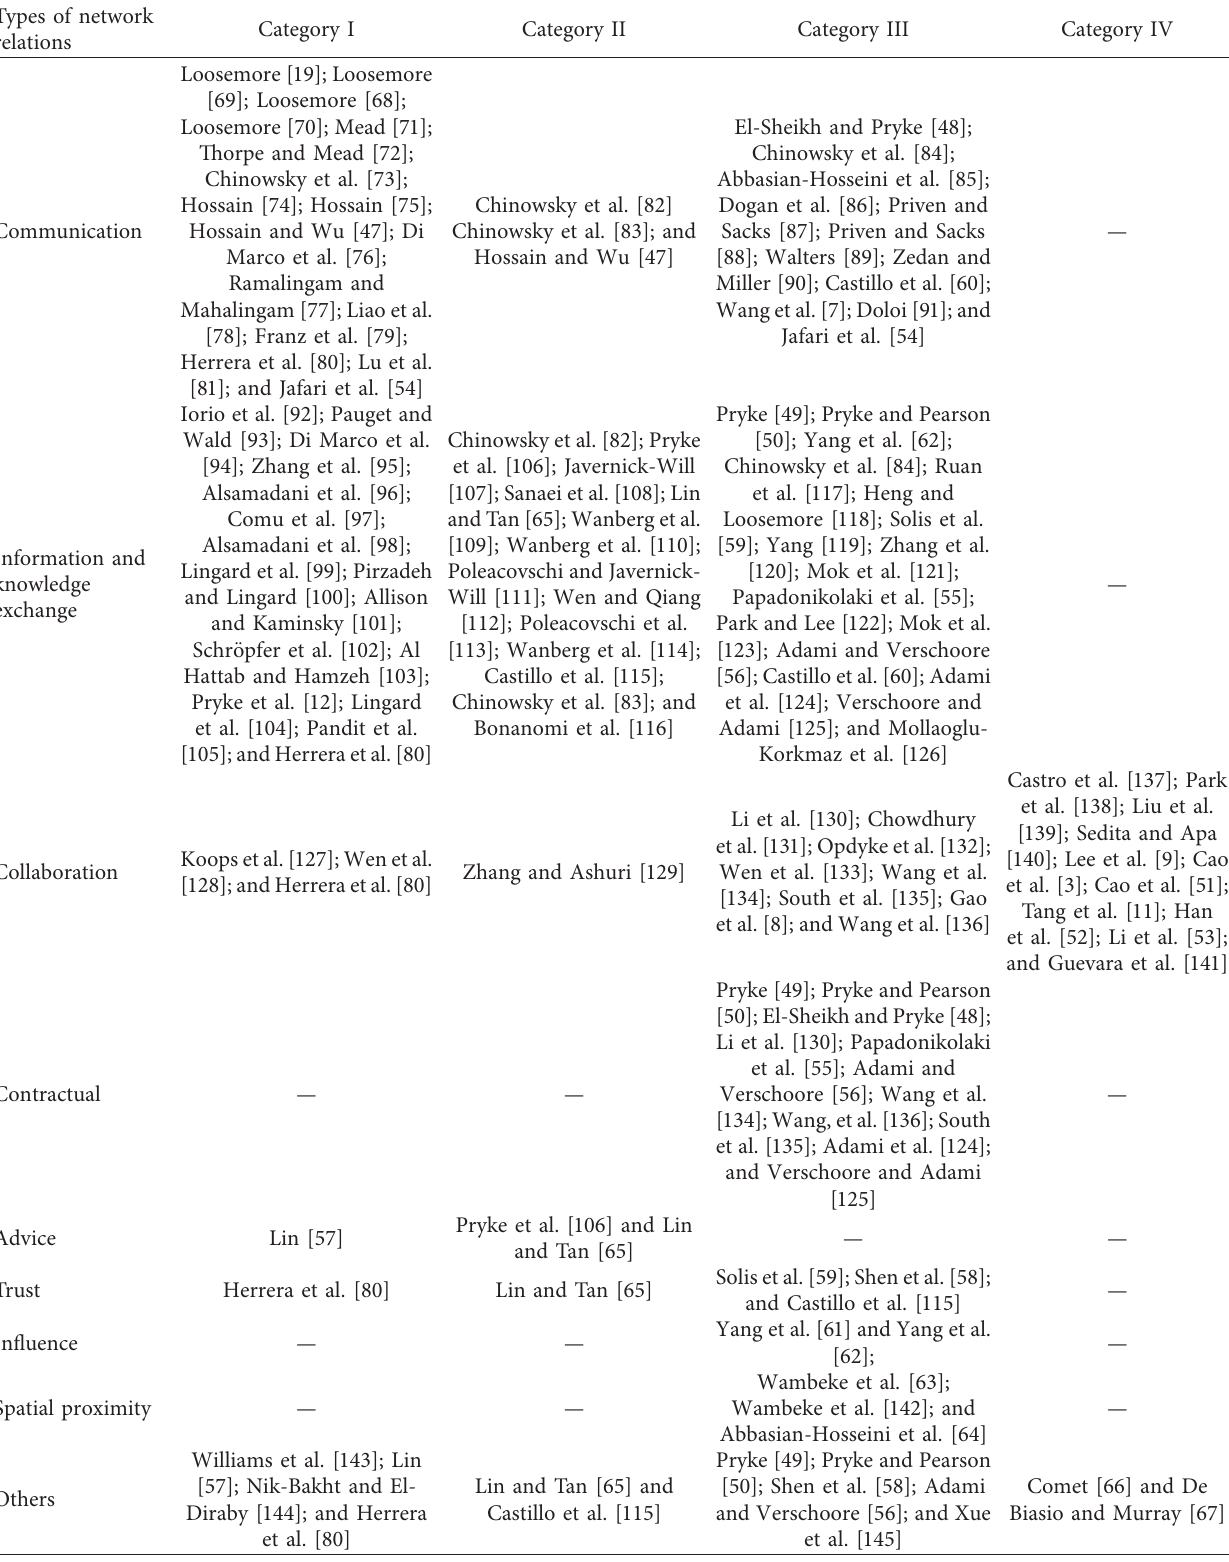
Table 5: Distribution of publications by types of network relations and categories of network